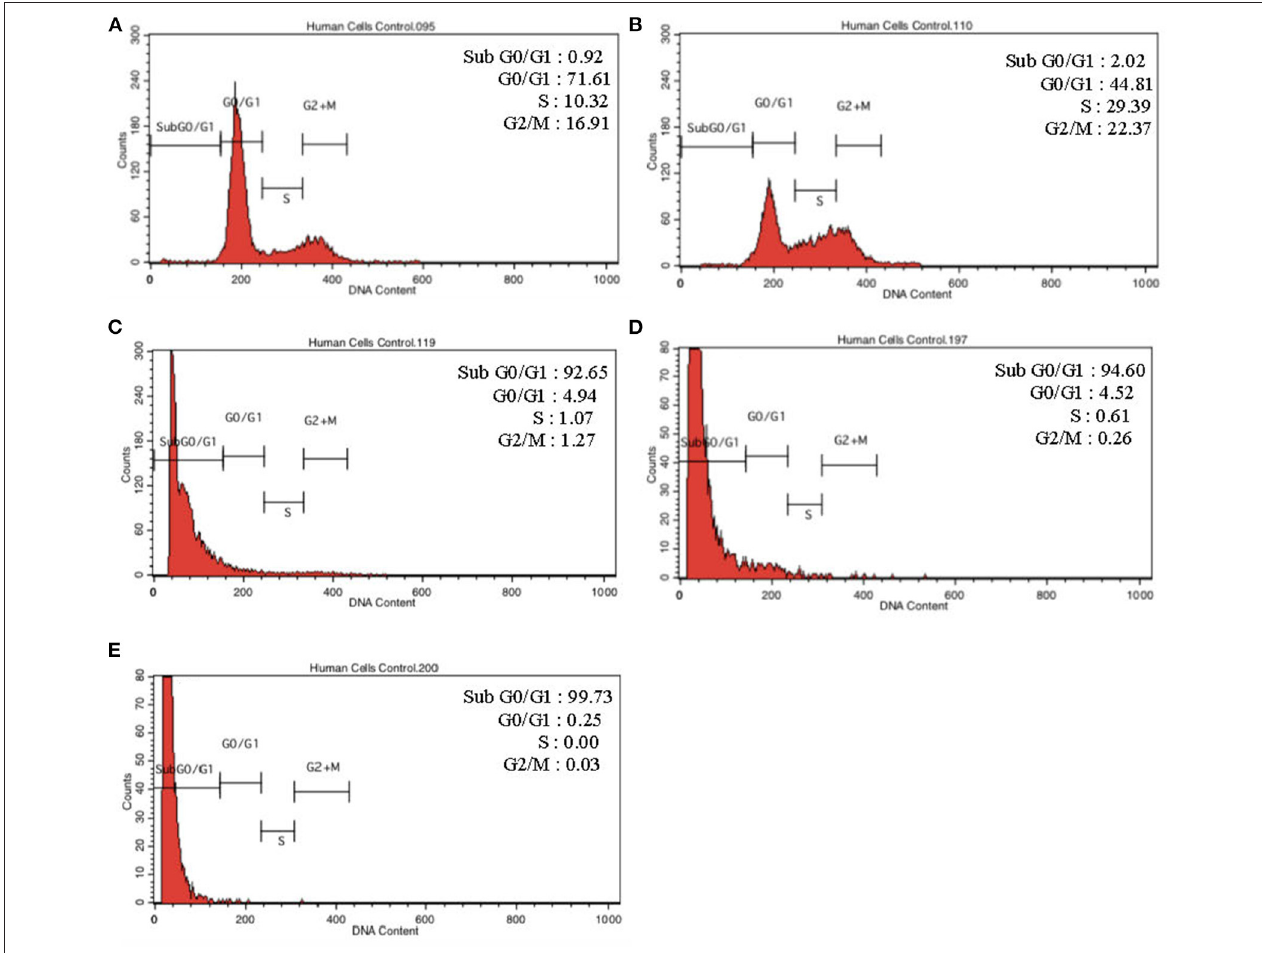
FIGURE 11 | Cell cycle distribution analysis in LPS-preconditioned cells by using flow cytometry. Cells were treated with 9 µ g/mL LPS for (A) . Control, (B) . 12, (C) . 24, (D) . 48, and (E) . 72h. Representative flow cytometry patterns from three independent experiments are